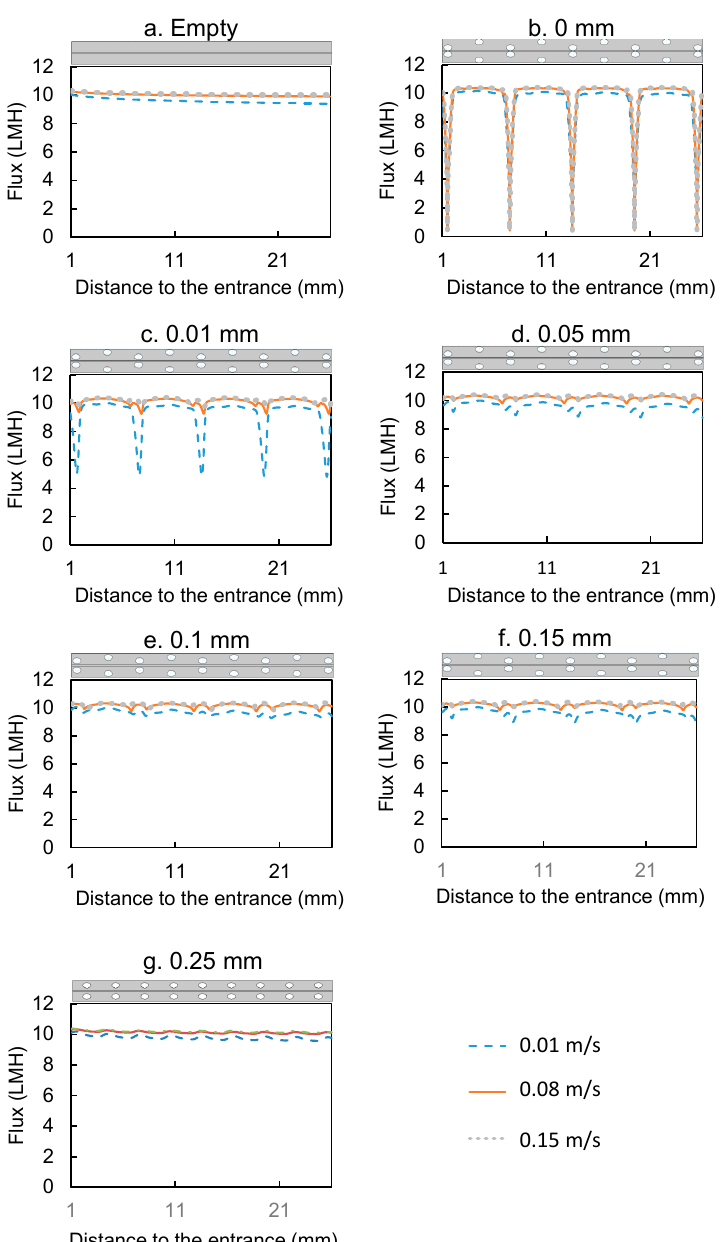
Figure 9. Water fluxes under different velocities along the membrane surface from the empty flow channel and the spacer-filled flow channels with various membrane–filament distances. The first and last 1 mm of the channel were excluded to remove entrance and exit effects. The sketch of the part of the channel whose data are presented is placed above the corresponding plot to illustrate the location of the spacer inside the membrane channel.